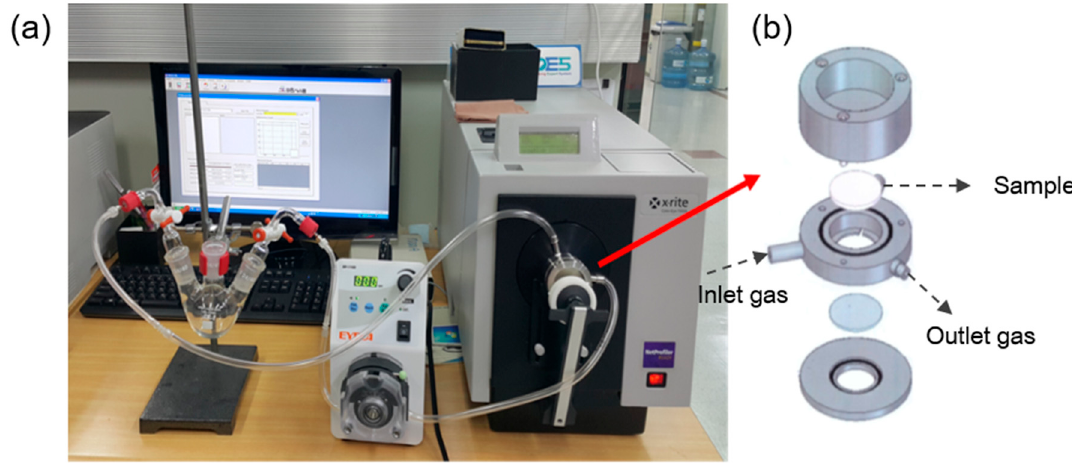
Figure 3. Color measurement system connected with a gas flow device [20]: ( a ) picture of our entire b ) schematic diagram of the chamber with a loaded system and ( b ) schematic diagram of the chamber with a loaded sample. system and (